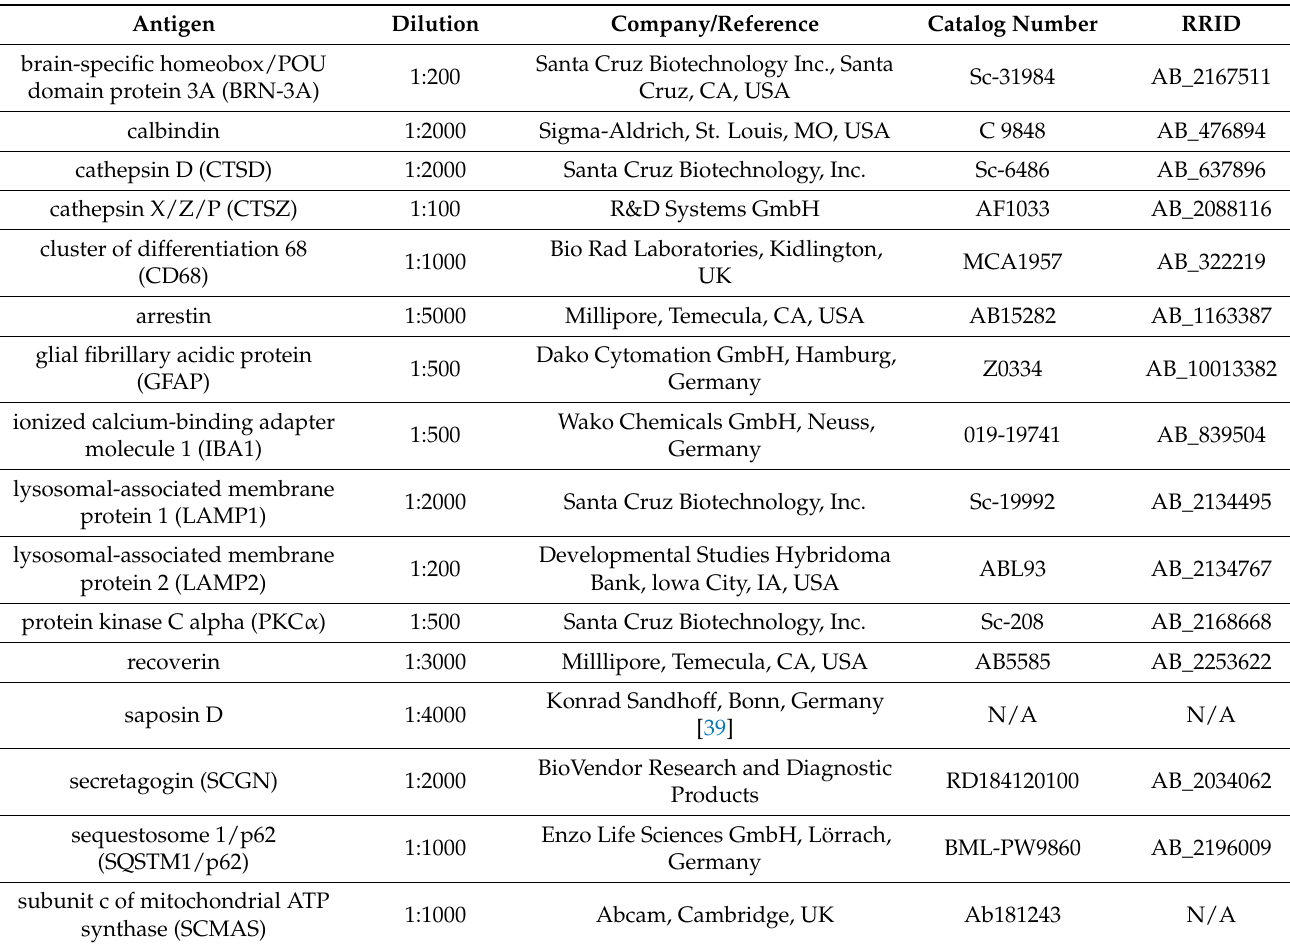
Table 1. Primary